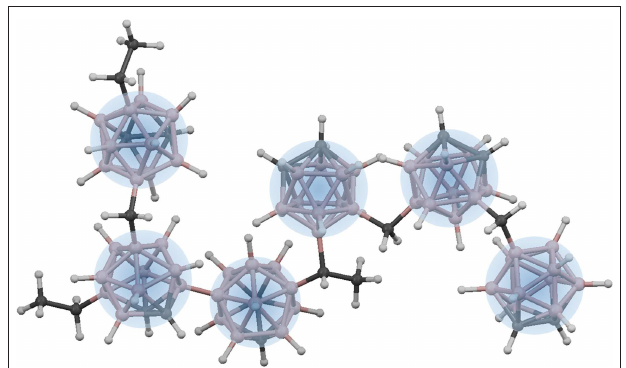
FIGURE 4 | “Superatom”-based network in polymeric a-BC:H (with minimal cross-linking shown for simplicity). Each icosahedron is treated as a constrained superatom with a total possible coordination of